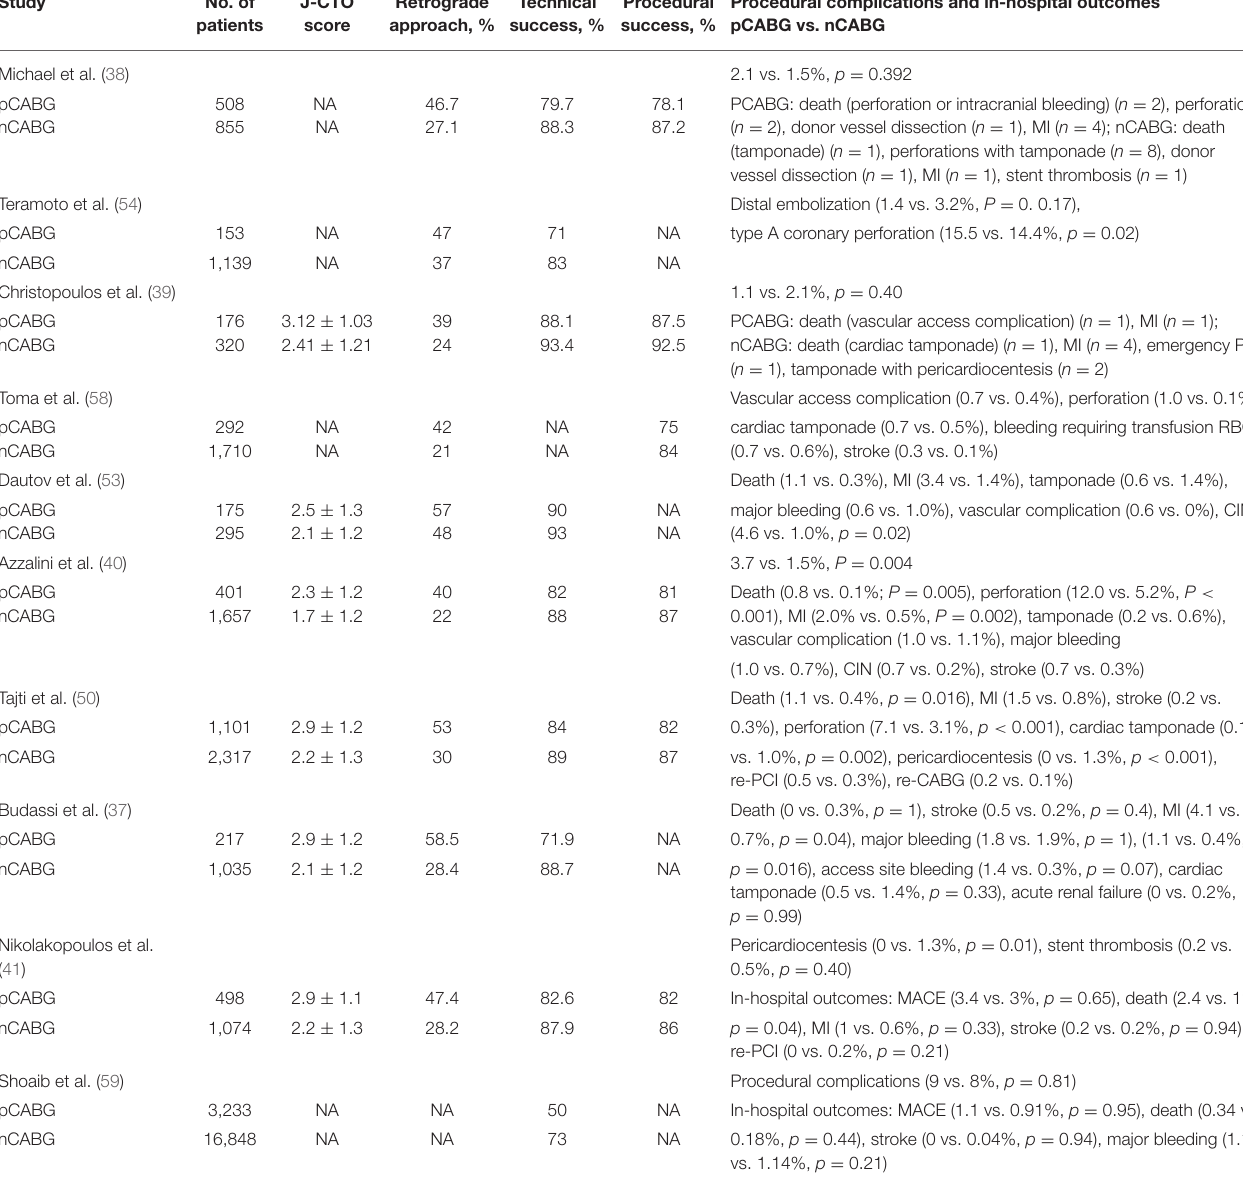
TABLE 1 | Recent studies of CTO-PCI in patients with prior CABG.